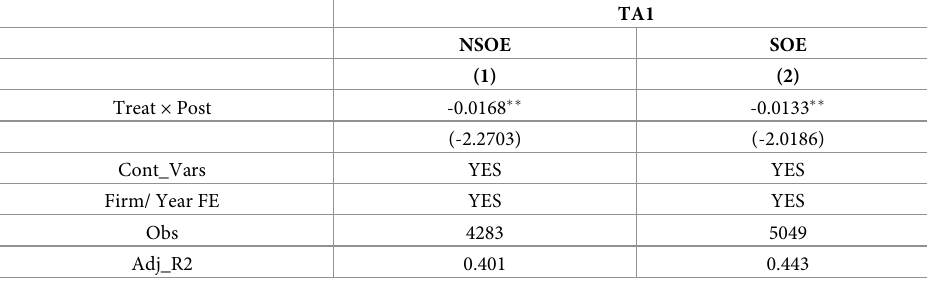
Table 6. Heterogeneity analysis: Ownership structure.